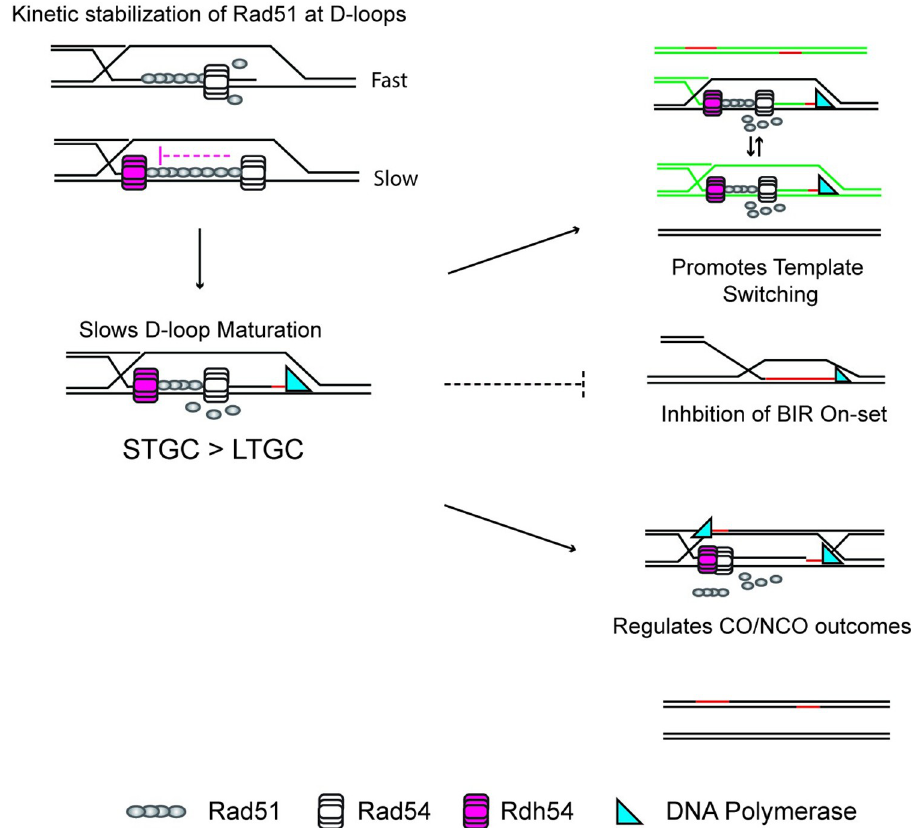
Fig 7. Model for how Rdh54 alters HR pathway choice. A cartoon diagram illustrating clearance of Rad51 when Rdh54 is present. Rdh54 slows the rate of Rad51 clearance leading to an increase in potential template switching, or a decrease in BIR initiation. Rdh54 translocation can then regulate NCO/CO outcomes through movement away from the D-loop. The effect on transitions from GC are greater for STGC than LTGC. The second step should also be considered possible through SDSA. Note exact position of Rdh54 relative to Rad54 in the D-loop is currently unknown, and our positioning is speculative.